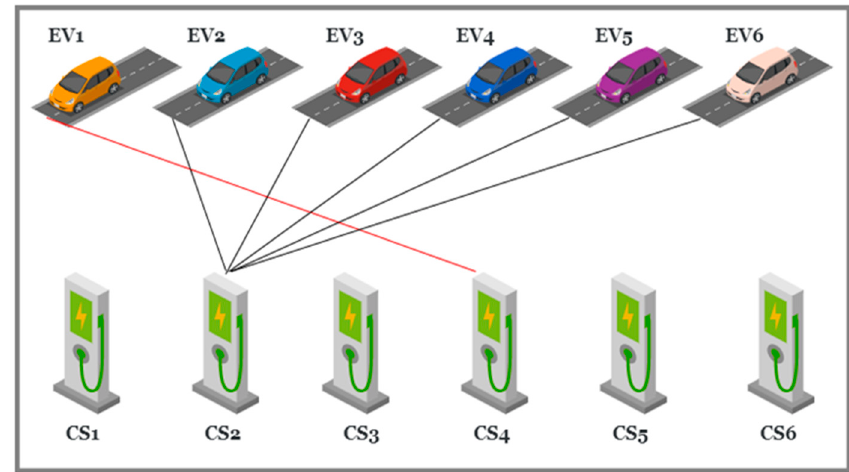
Figure 11. Assignment of EVs according to the shortest way.